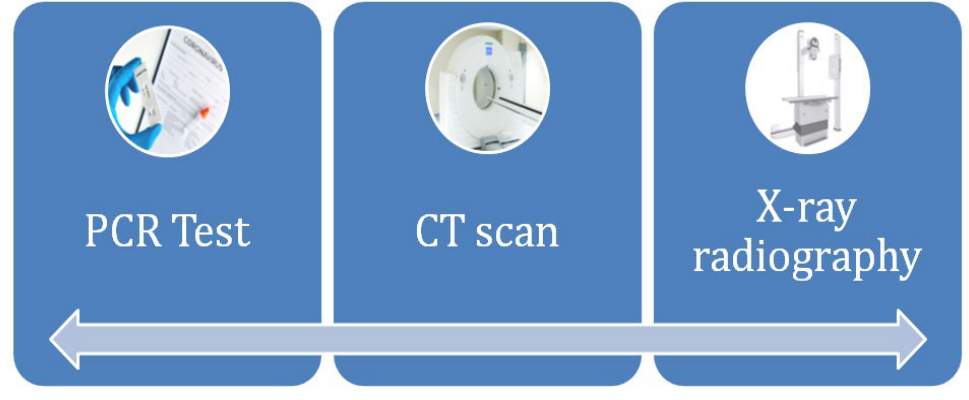
Figure 1. The standard protocol for COVID-19 diagnosis.